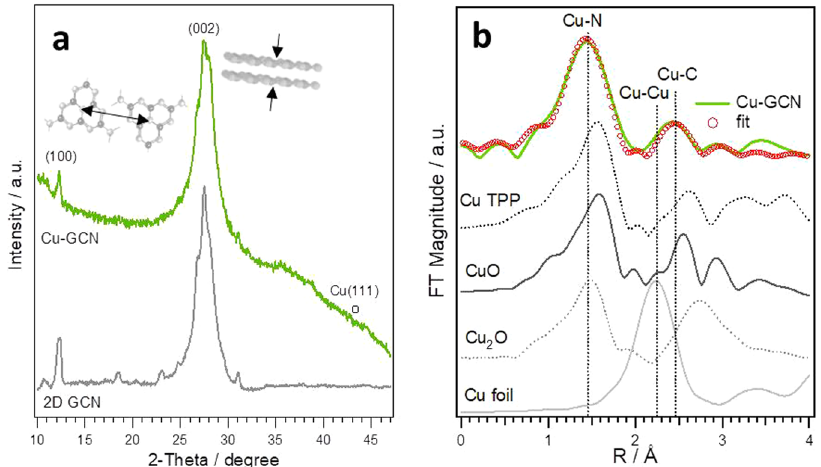
Fig. 2 Structural characterization of Cu-GCN. a XRD diffraction patterns of 2D GCN and Cu-GCN(20); and b not phase shift corrected FT EXAFS spectra, and corresponding fi t, for Cu-GCN(20). The FT EXAFS spectra for the samples used as reference have been included in ( b ) for